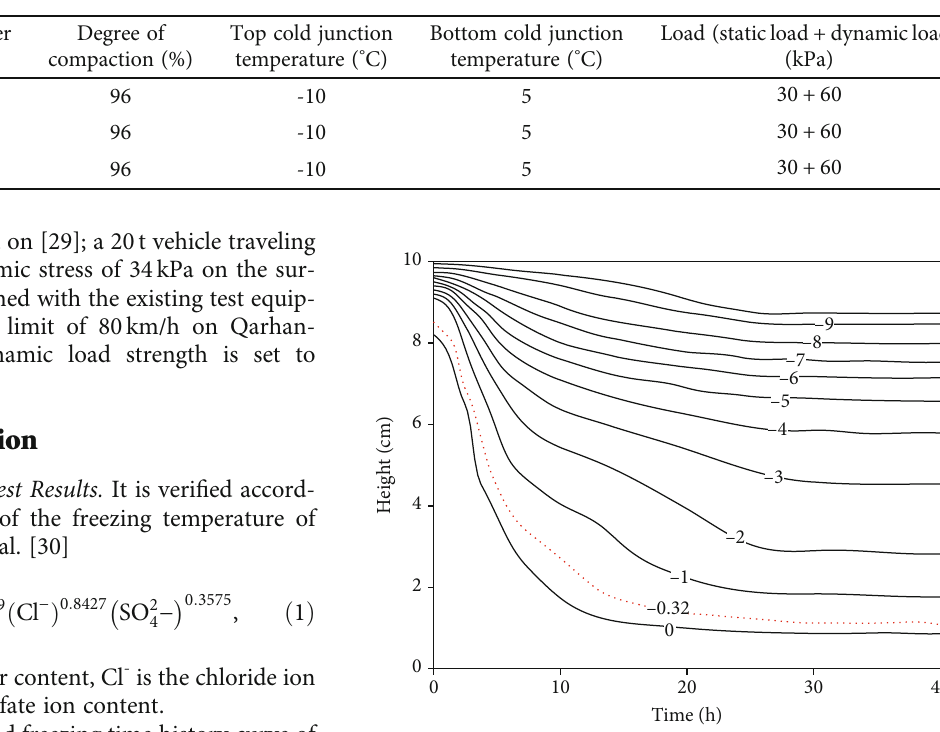
Table 3: Soil test condition.